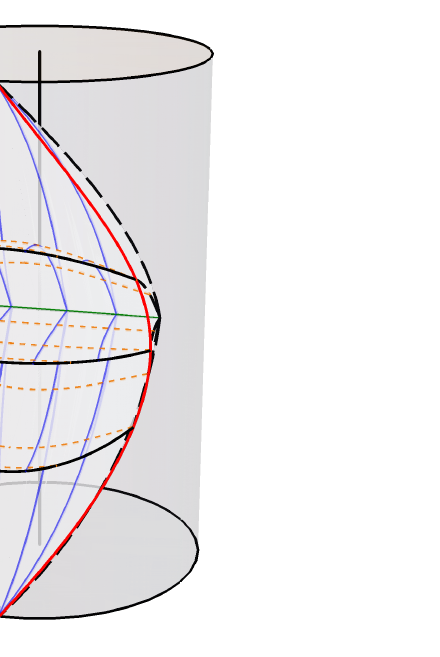
The Class II left black hole. Several surfaces of constant t are shown; those of large positive and negative t outline the event horizon. The surface x = x + — shown in dashed black — is identified with its partner within each time-slice. The bifurcation surface of the Killing horizon is shown in green and has topology S 1 . Lines of constant x and y are shown in solid blue and dashed orange respectively. The classically accessible region of the conformal boundary is delimited in red.